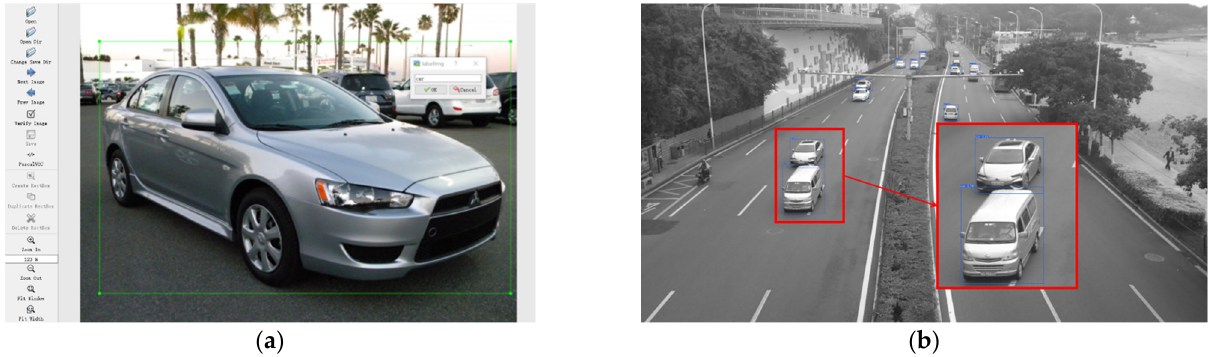
Figure 4. ( a )Label the vehicle using the data labeling tool. ( b )Vehicle detection by